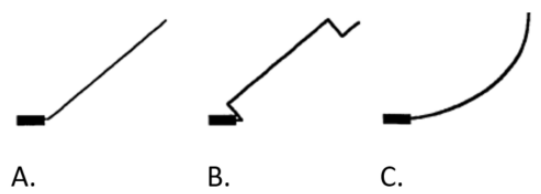
Figure 1. Symmetric activation of 10 mm UA (typodont).